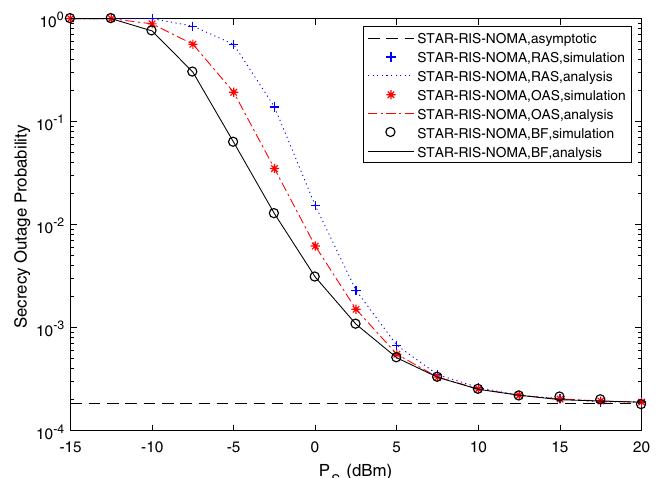
Fig. 2 The SOP versus the transmit power for multi-antenna STAR-RIS-aided NOMA network. the SOP of three schemes: RAS, OAS and BF